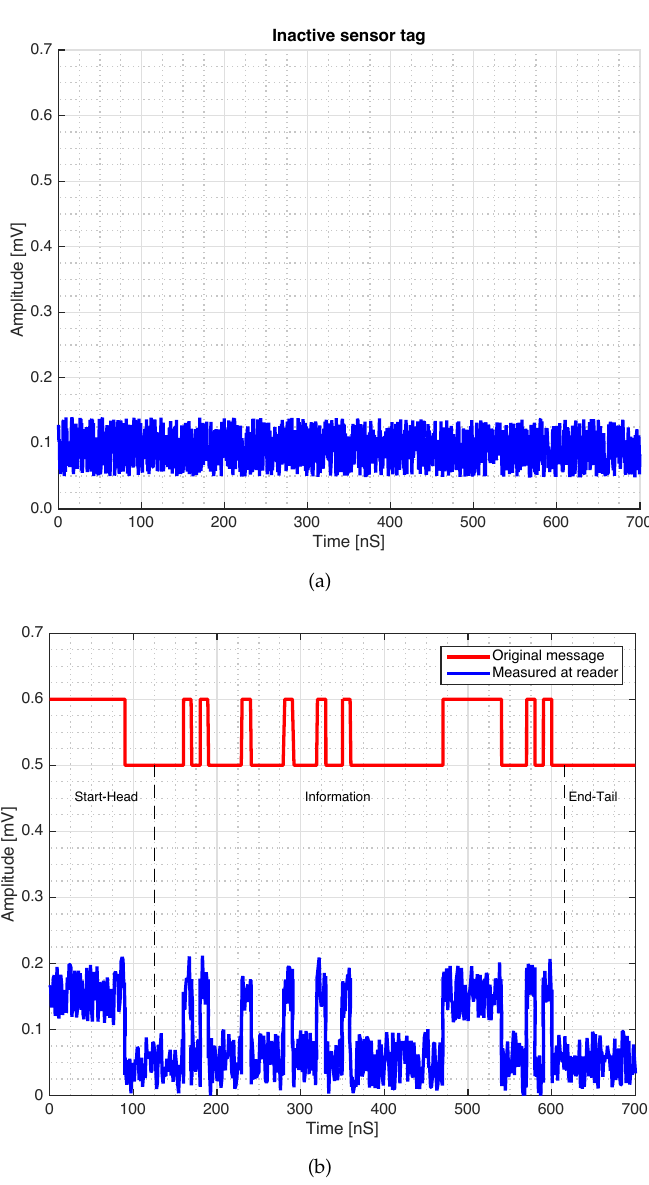
Figure 6. Signal detected at the reader output ( a ) inactive and ( b ) active sensor response. The signal has been generated with a MST tag equipped with a microprocessor to implement the EM4102